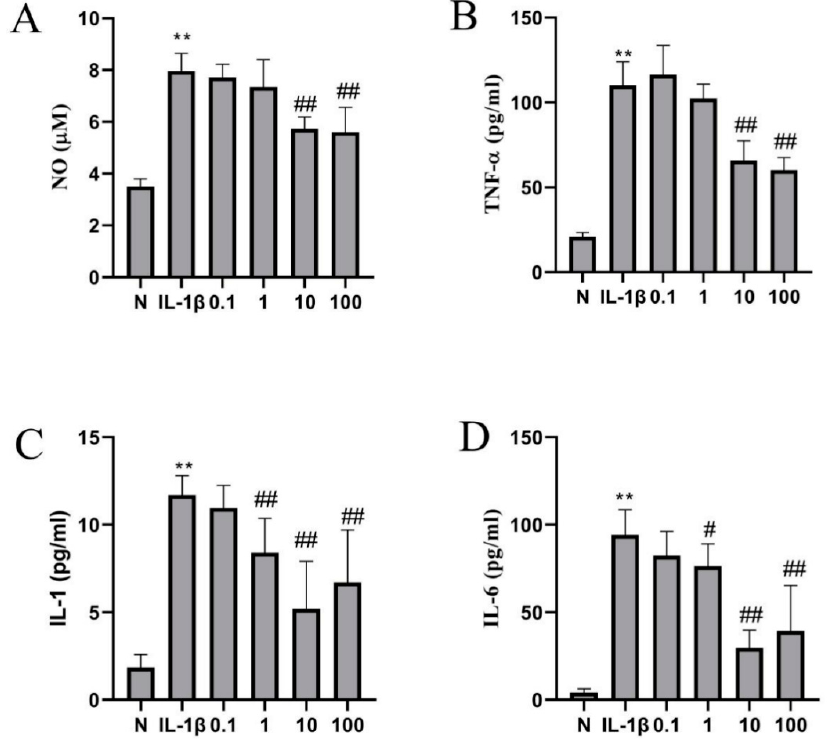
Figure 4. The effect of catalpol on the secretion of nitric oxide and inflammatory cytokines of chondrocytes induced by IL-1 β . ( A ) NO, ( B ) TNF- α , ( C ) IL-1, ( D ) IL-6. The data are the mean ± S.D. of the mean (n = 6). ** p < 0.01 vs. normal group (N); # p < 0.05 vs. IL-1 β group; ## p < 0.01 vs. IL-1 β group.